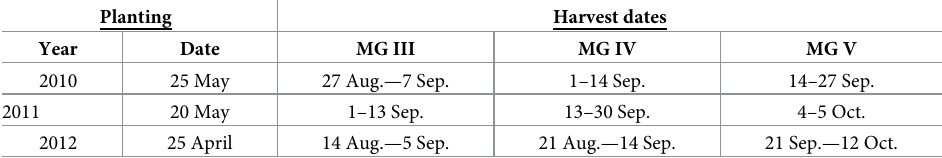
Table 2. Planting and harvest dates for evaluation of soybean for reaction to natural field infection by Cercospora species in Stoneville, Mississippi, in 2010, 2011, and 2012. Planting